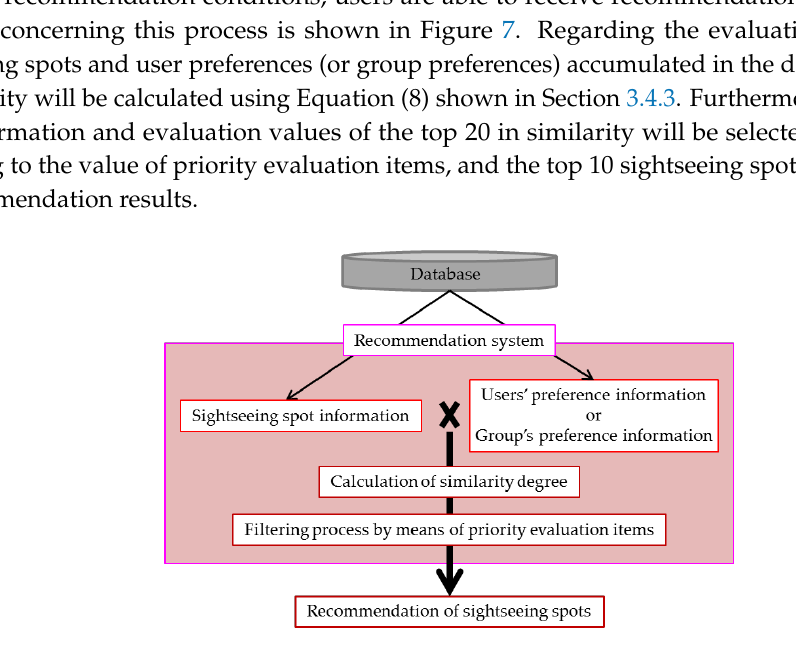
Figure 7. Conceptual diagram concerning the recommendation system.